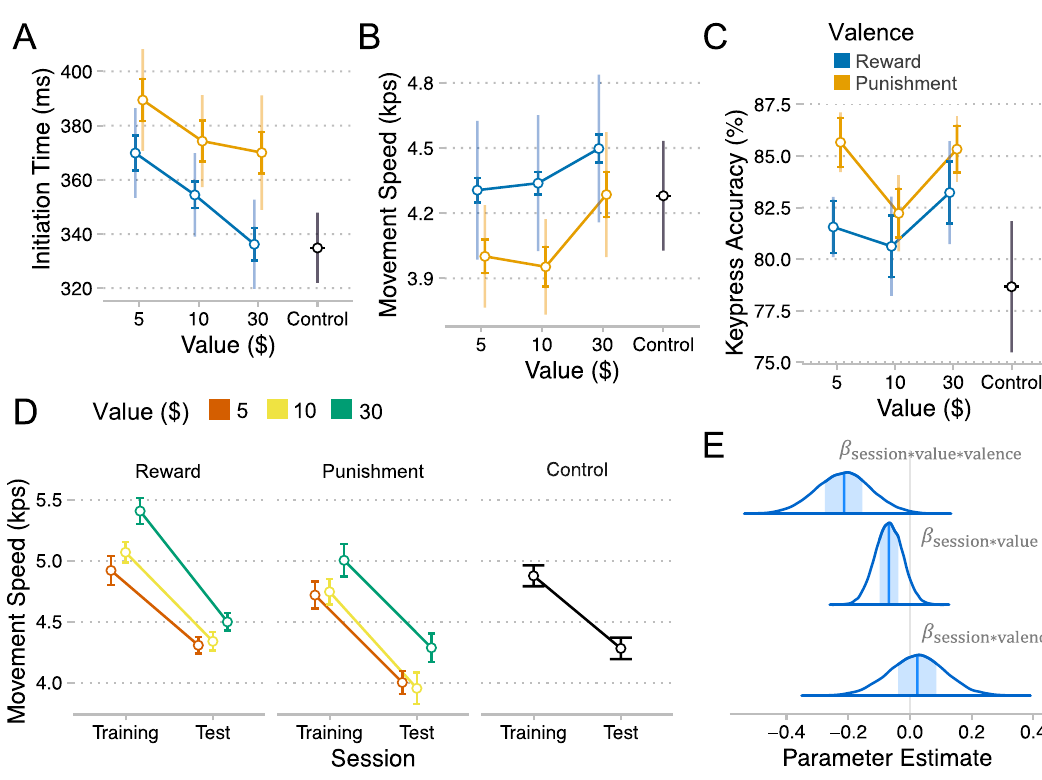
Figure 5. Effects of training incentives on performance retention. ( A ) Initial reaction time (mean + /- se) for each level of value by valence in the test. ( B ) Movement speed for each level of value by valence in test. ( C ) Keypress accuracy for each level of value by valence in test. ( D ) Change in speed from the end of training (blocks 7 – 9) to the retention test for each level of value by valence. E. Densities of MCMC samples used to approximate posterior probability distributions over key regression coefficients in our model of performance (MT) retention. Plots were created using ggplot2 46